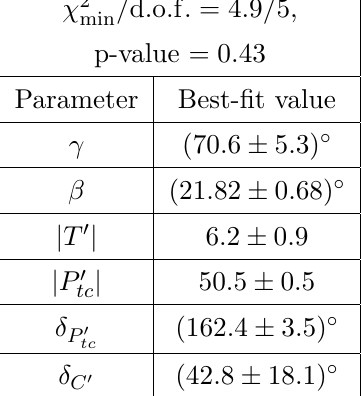
Table 5 . (cid:31) 2 = d : o : f : and best-(cid:12)t values of unknown parameters in amplitudes of eq. (2.1). Con- min straints: B ! (cid:25)K data, measurements of (cid:12) and (cid:13) , theoretical inputs j C 0 =T 0 j = 0 : 5, P 0